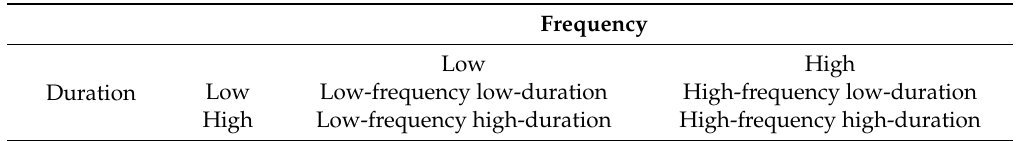
Table 1. Generation of the binary omnibus measure of green space